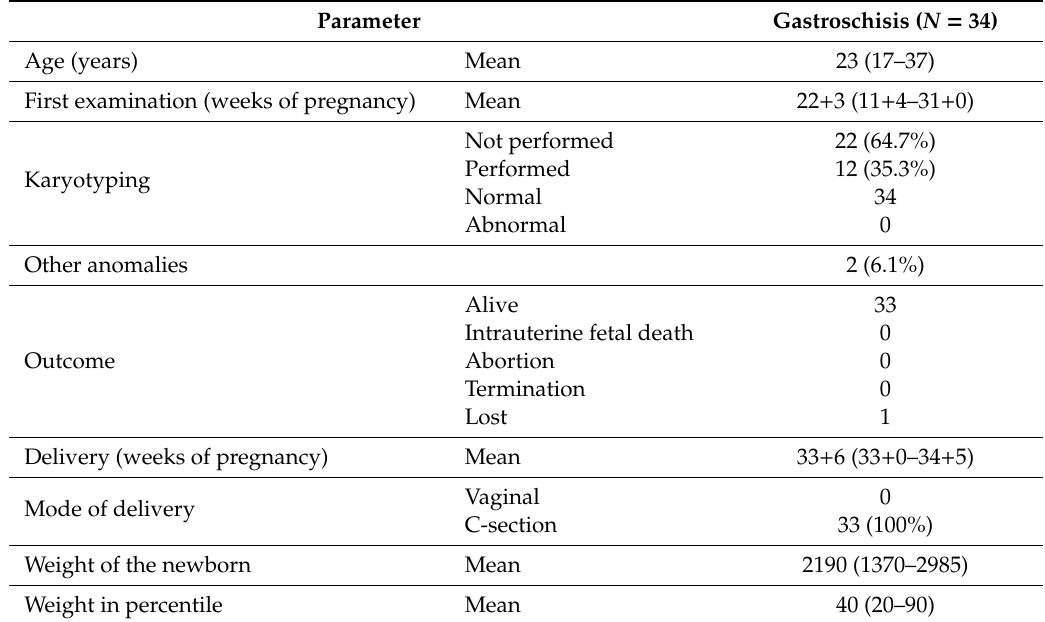
Table 1. Maternal characteristics and outcomes of cases with gastroschisis.